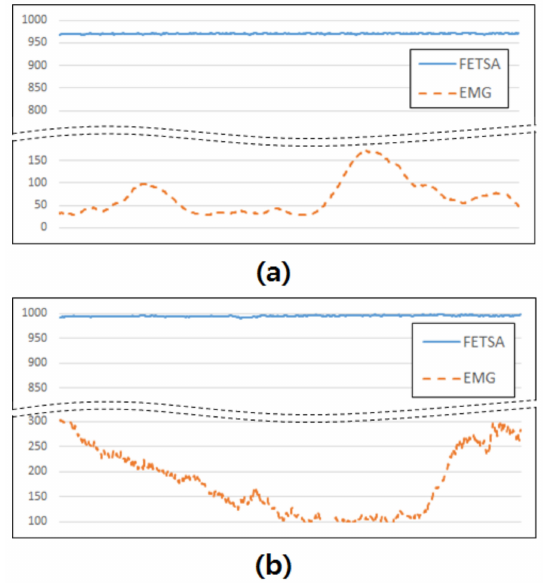
Figure 9. Comparison of the results using FETSA and EMG. ( a ) When the subject remained motionless. ( b ) When the subject produced the “thumbs-up”